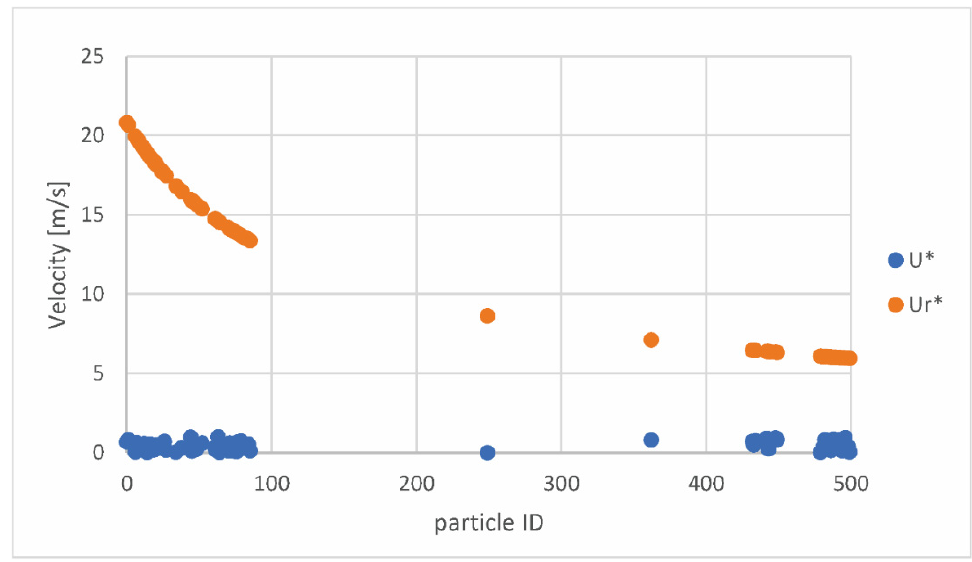
Figure 13. Dependence of wall shear velocity for rolling on particle ID.